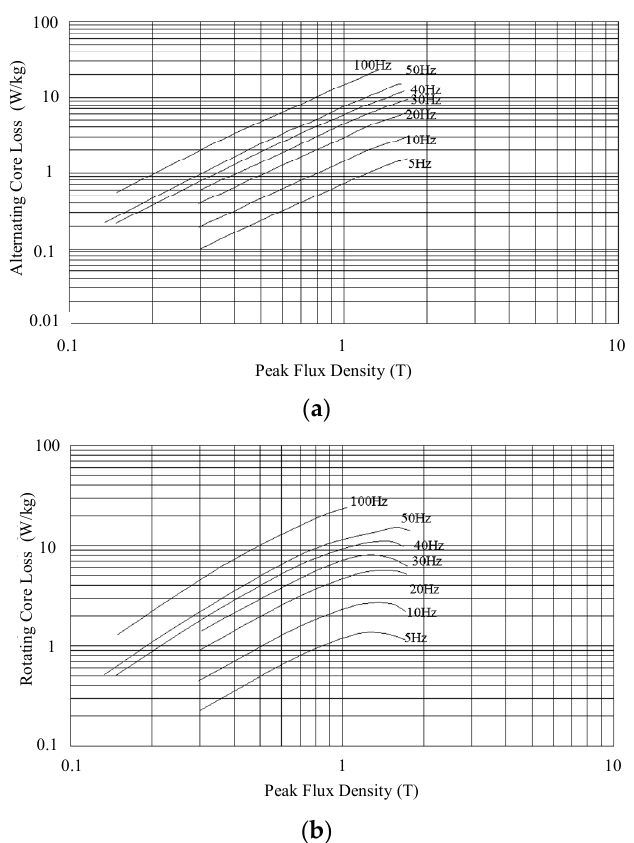
Figure 6. Measured core losses of SMC sample: ( a ) with alternating flux, and ( b ) with circularly rotating flux [156].